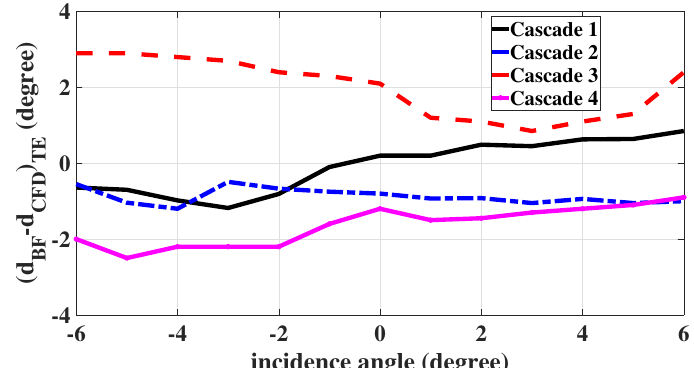
Figure 6. Comparison between deviation from Hall’s body force model and bladed CFD for the 4